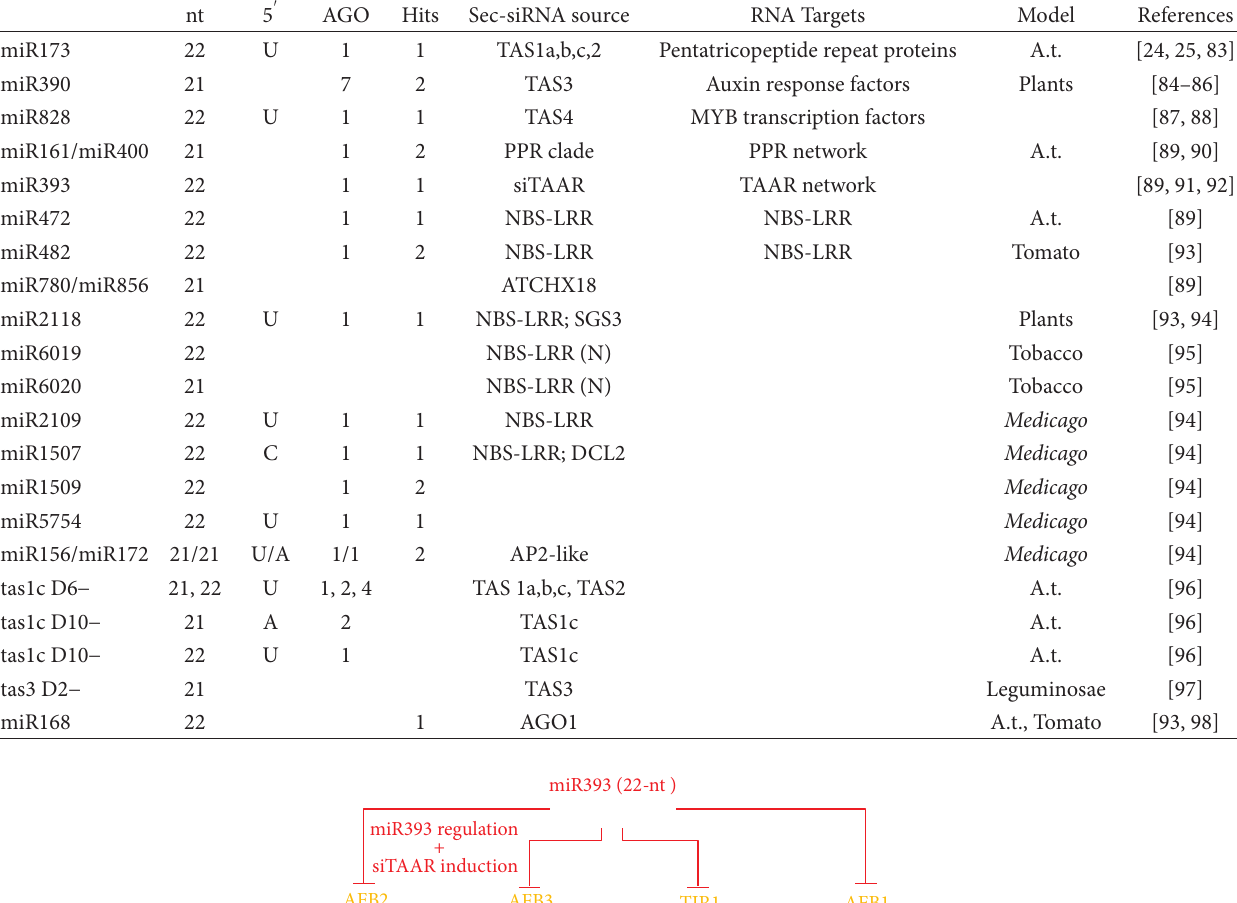
T 1: MicroRNAs and ta-siRNAs targeting RNAs for secondary siRNA production.